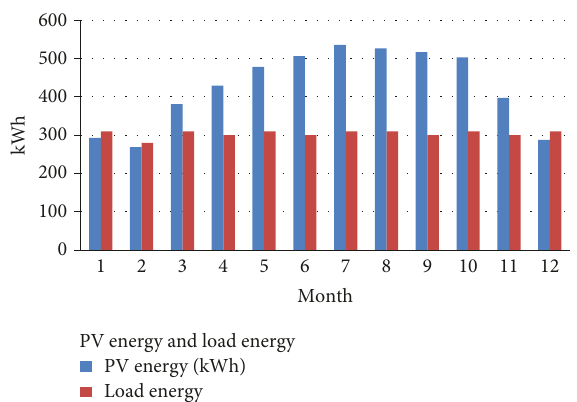
Figure 6: The monthly energy produced by the 3.2 kWp PV system and the load consumption.